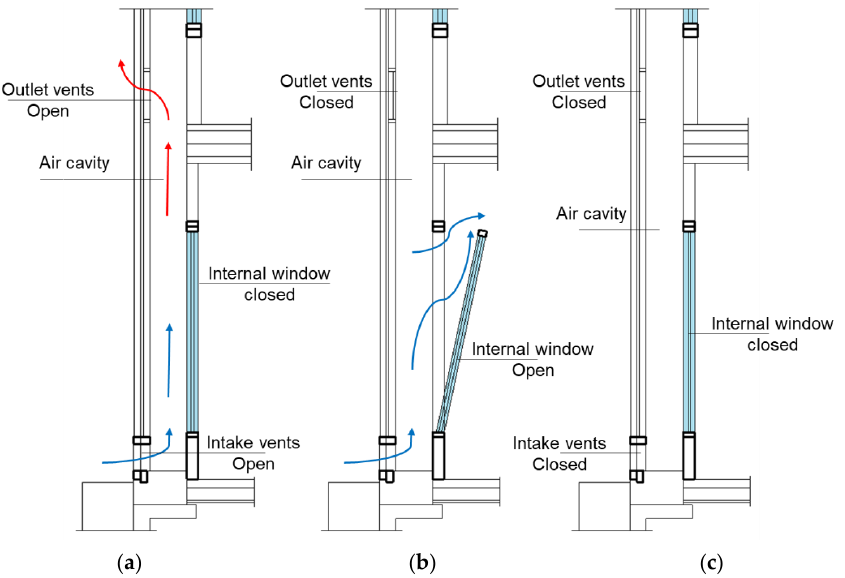
Figure 17. Adaptive ventilated facades with controlled thermal characteristics. ( a ) summer daytime, ( b ) summer night, ( c ) winter.